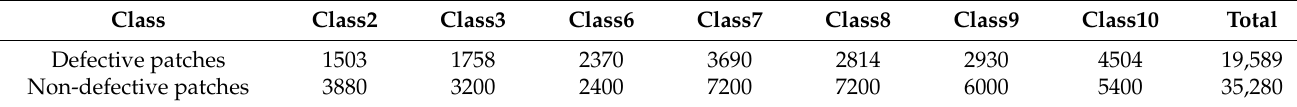
Table 2. The number of training patches of each class in the wavelet